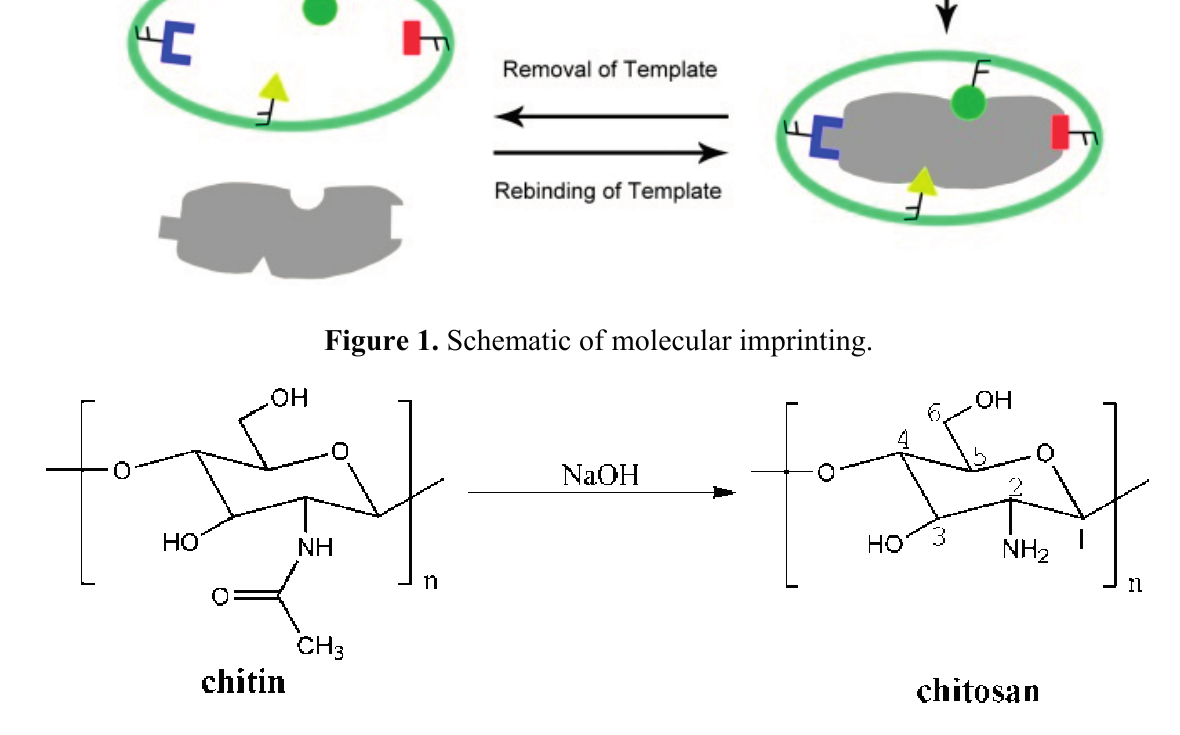
Figure 2. Deacetylation of